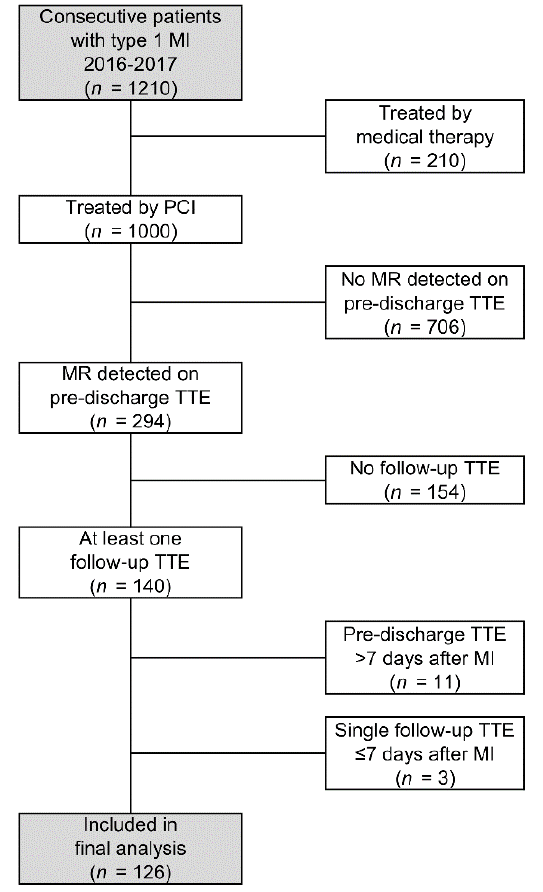
Figure 1. Study flowchart. MI = myocardial infarction; MR = mitral regurgitation; PCI= percutaneous coronary intervention; TTE= transthoracic echocardiography.